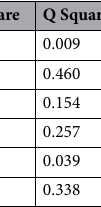
Table 3. R 2 and Q 2 Values of Measurement